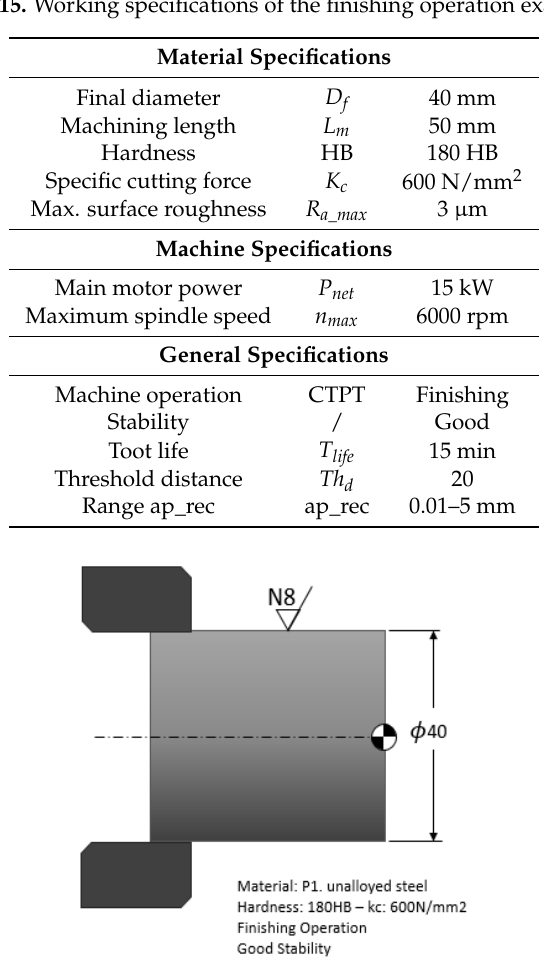
Figure 14. Example of a finishing operation.